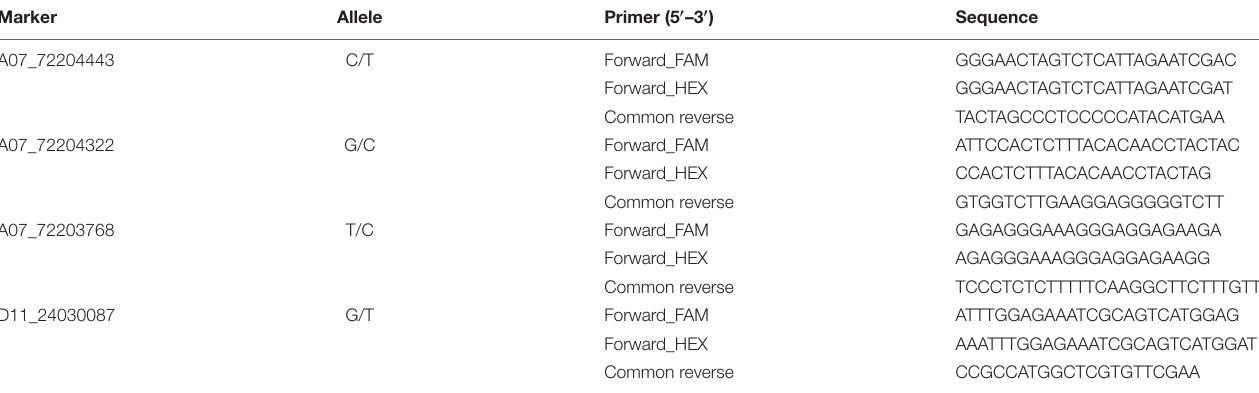
TABLE 1 | List of primer sequences used for KASP assays. Marker Allele Primer (5 (cid:48) –3 (cid:48) )